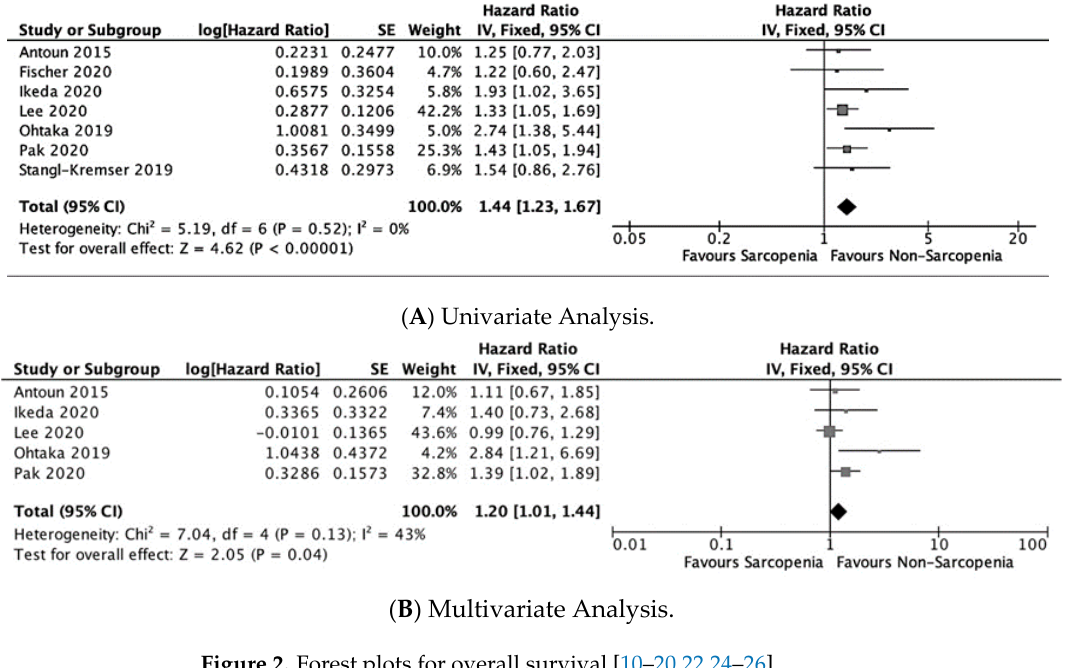
Figure 2. Forest plots for overall survival [10 – 20,22,24 – 26].